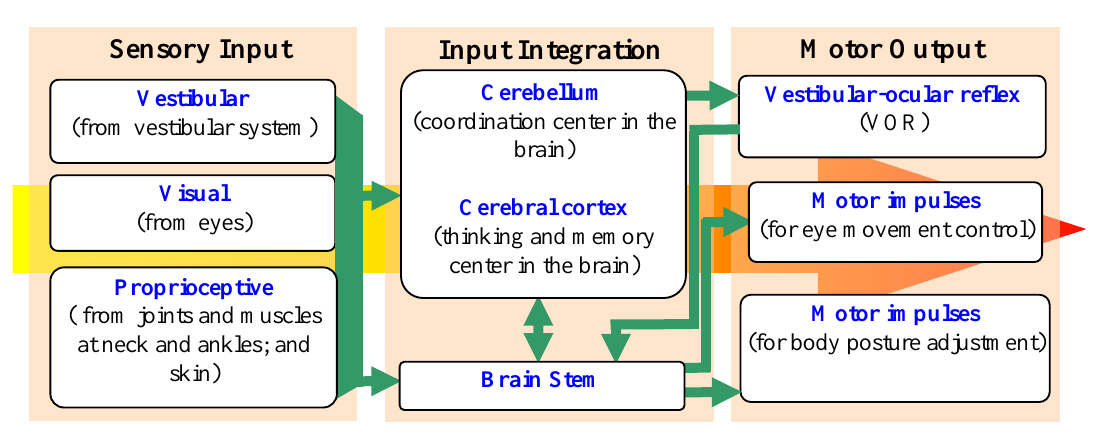
Figure 3. Balance control in human